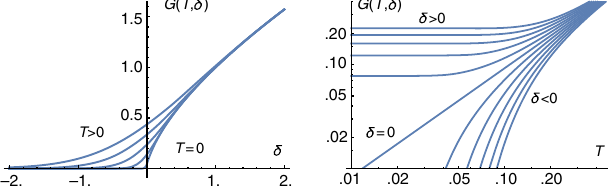
FIG. 1. Critical behavior of the edge tunneling conductance G as a function of temperature T and tuning parameter δ near the 3D Ising critical point. Panel (a) shows G as a function of δ for several values of T , highlighting the zero-temperature behavior in which G ð 0 ; δ Þ ∼ θ ð δ Þ δ 2 β . Panel (b) shows G as a function of T for several values of δ , highlighting the behavior at the critical point G ð T; 0 Þ ∼ T m þ η